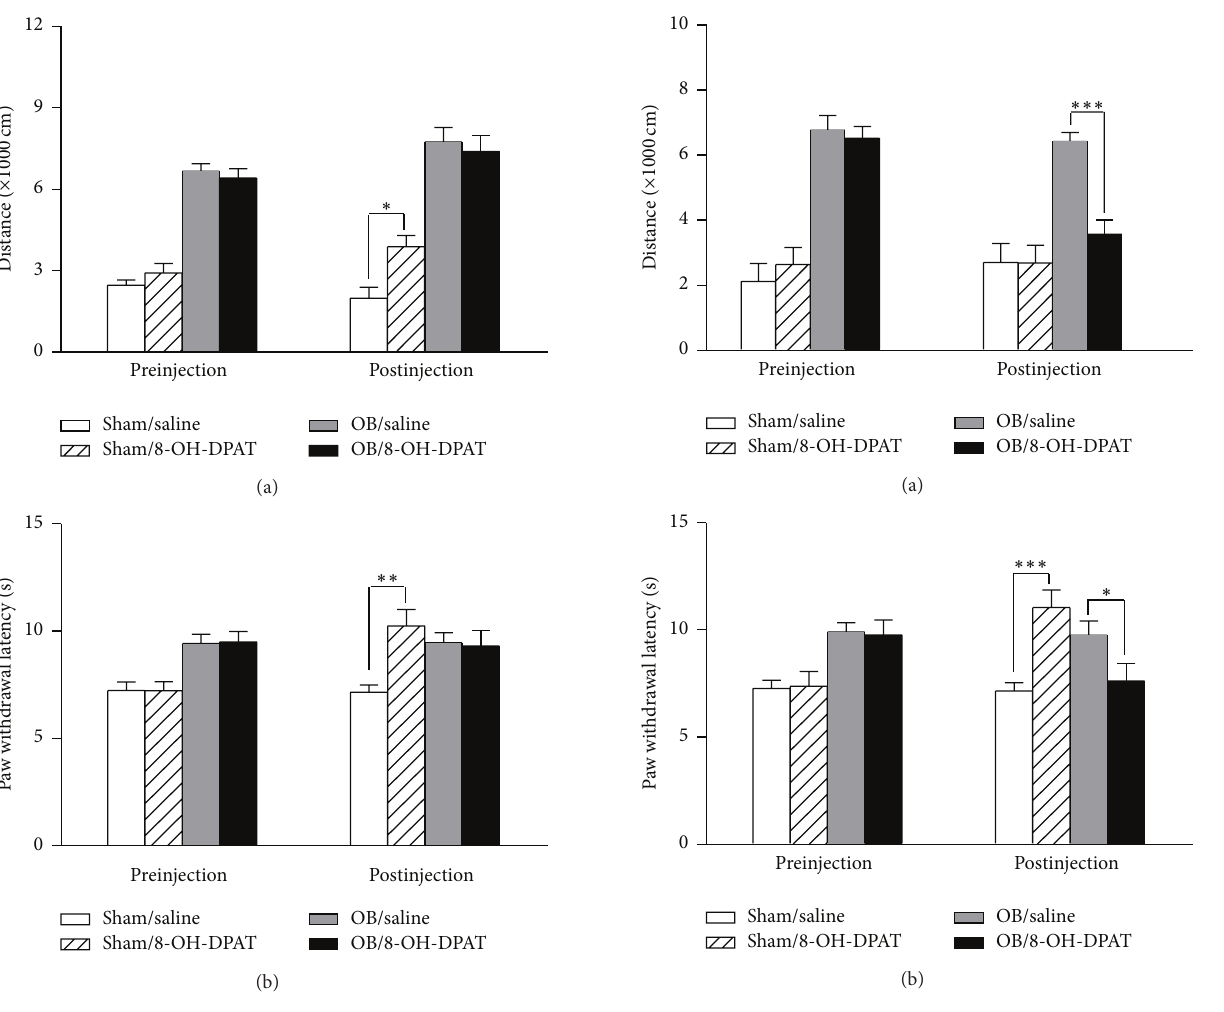
Figure 3: Effects of acute administration of 8-OH-DPAT. Acute 8-OH-DPAT treatment significantly increased locomotor activity ( 𝑛 = 8 – 12 ) (a) and pain thresholds ( 𝑛 = 8 – 12 ) (b) in the sham- operated rats but have no effect on the OB rats. Data are presented as mean ± SEM. ∗ 𝑃 < 0.05 , ∗∗ 𝑃 < 0.01 . (two-way ANOVA, 9.76 ± 0.66 s versus 7.62 ± 0.83 s, 𝑃 <